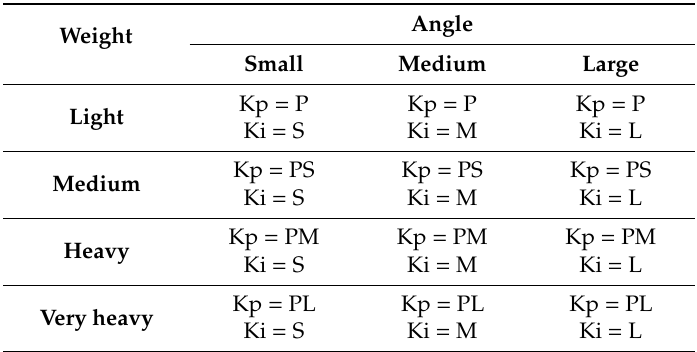
Table 4. A fuzzy rule